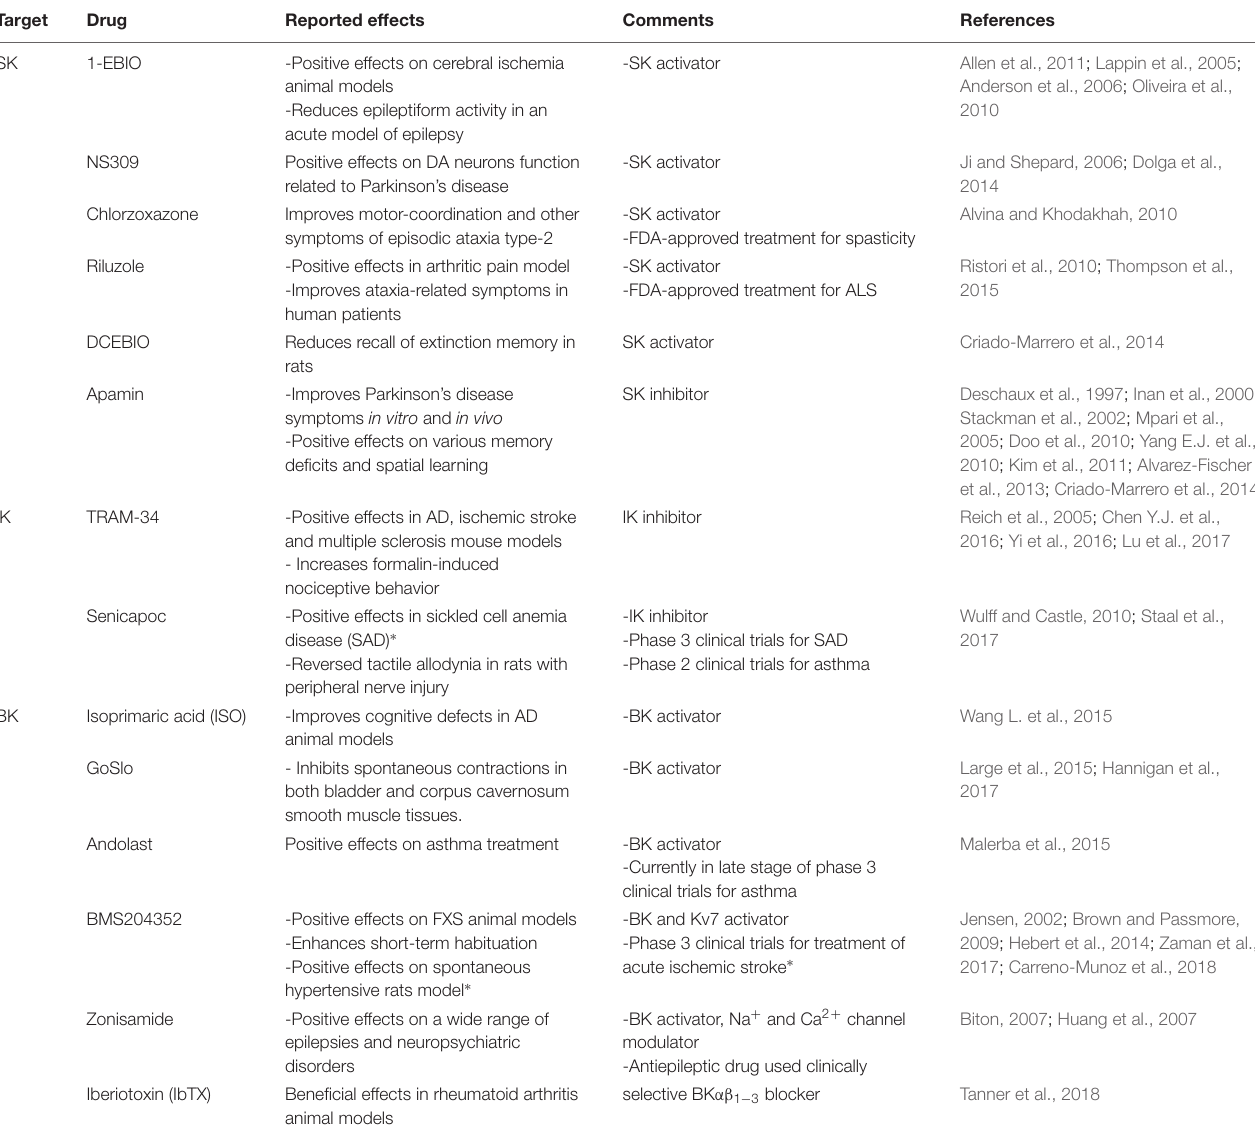
TABLE 2 | Functional roles of clinically available/potential modulators of K Ca